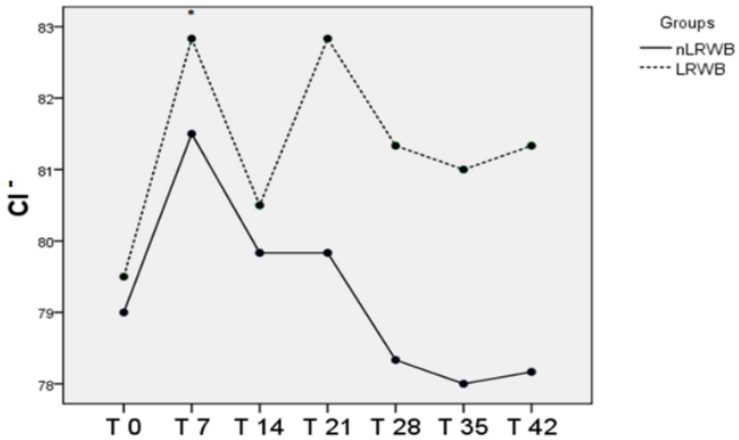
Figure 7. Differences in Cl − (mean) measured in nLRWB and LRWB units, during the storage period. The days of storage are presented in the x-axis. Cl − (mEq/L) is presented in the y-axis. Asterisks * p < 0.05.